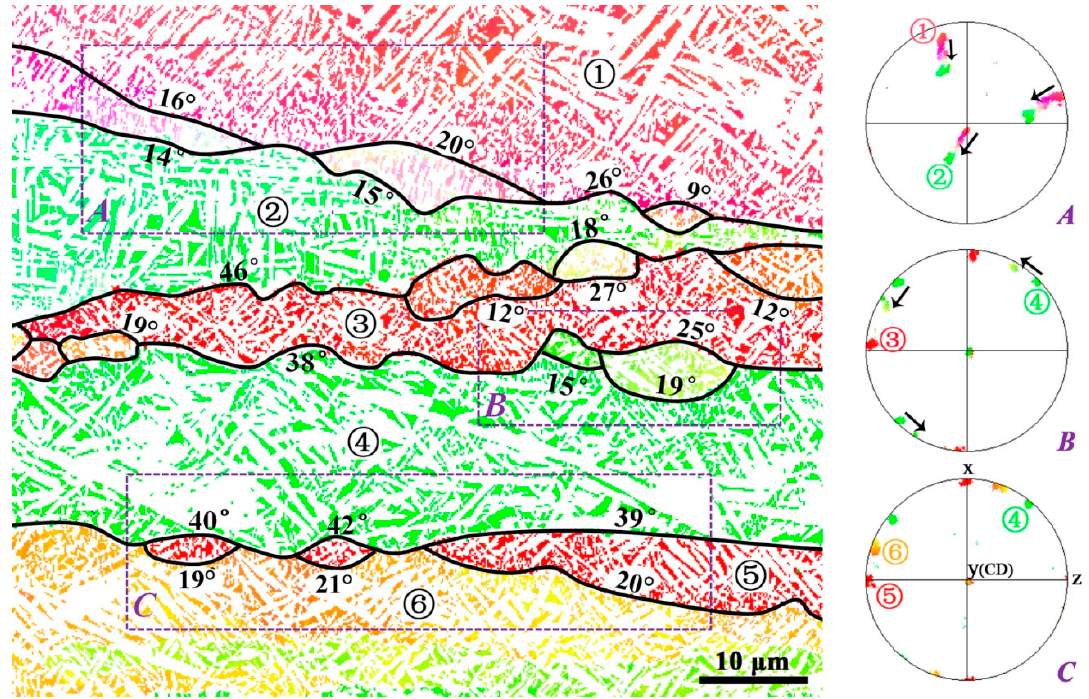
Figure 3. Local inverse pole figure map for the β phase after deformation at 2 s − 1 , by using a step size of 0.15 μ m. Some grain boundaries are outlined by solid lines to show the dynamic recrystallized (DRXed) grains, and the corresponding grain boundary misorientations are also indicated. For the micrograph, the compression direction is vertical. {100} pole figures for three local regions are presented to show the rotation tendency of local orientations. Note that the coordinate system for the pole figures are indicated, where y denotes the compression direction, x and z are the radial direction of the deformed